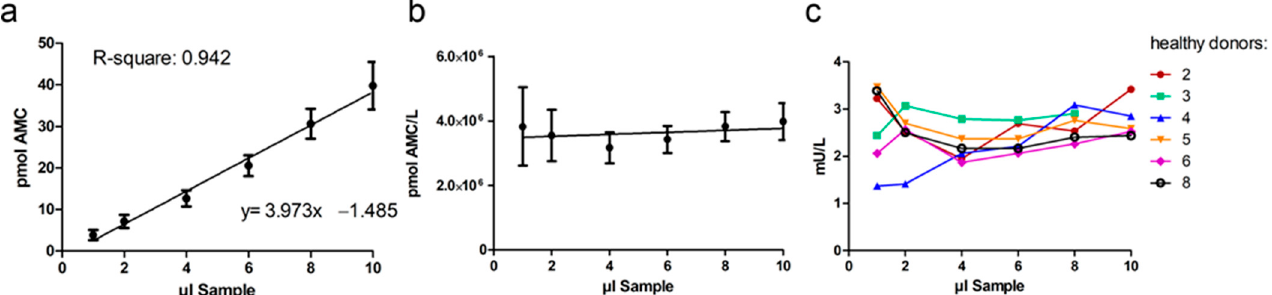
Figure 5. Dilution integrity. AGA activity was measured with different amounts of serum (1–10 µL) from healthy donors. All samples were diluted with NaCl or artificial serum to 20 µL total volume for the assay. AGA activity in the serum samples of six healthy donors was measured according to the validated protocol. ( a ) The mean values (pmol AMC) of the six healthy donors were used for linear regression analysis. ( b ) The mean AMC values back-calculated as pmol AMC per liter over the sample volume range; ( c ) Individual AGA activities (mU/L) in the serum samples of the six healthy donors.